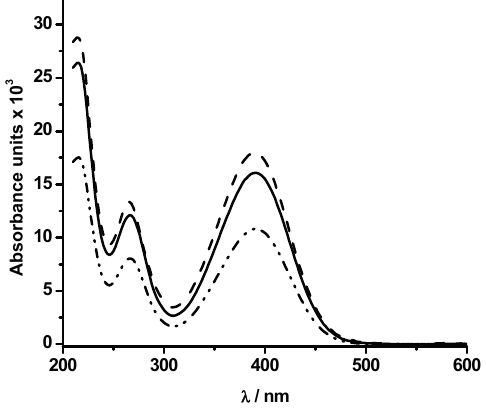
Figure 7. Time course of the reaction of PGR with HONO or peroxyl radicals followed by HPLC. PGR (20 µM) was incubated with HONO (300 µM) in SGM. Chromatograms were obtained ( λ = 380 nm) at different incubation times: A: 0 min; B: 10 min. and C: 110 min. D: Chromatogram obtained after 30 min of the PGR (20 µM) incubation with AAPH (10 mM) in phosphate buffer (pH 7.4) at 37 °C.